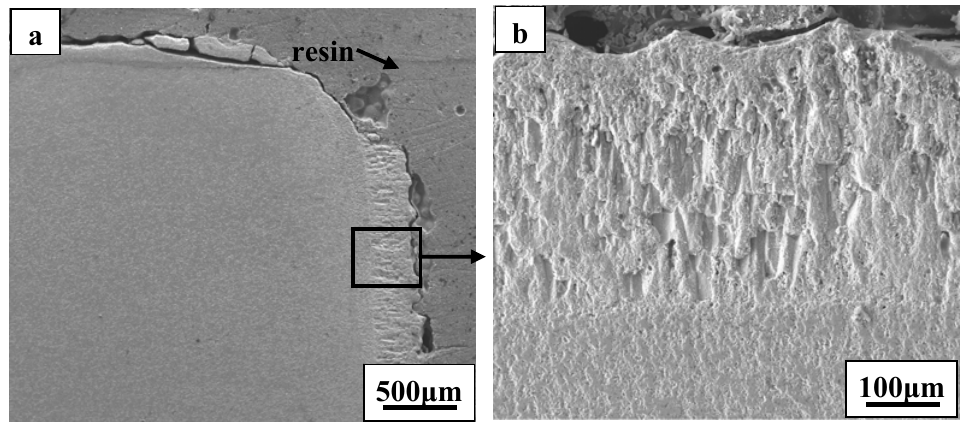
Figure 5. Cross-sectional morphologies of ZS10 after ablation under condition 1: ( a ) low magnification; ( b ) high magnification of the scale at the side surface.